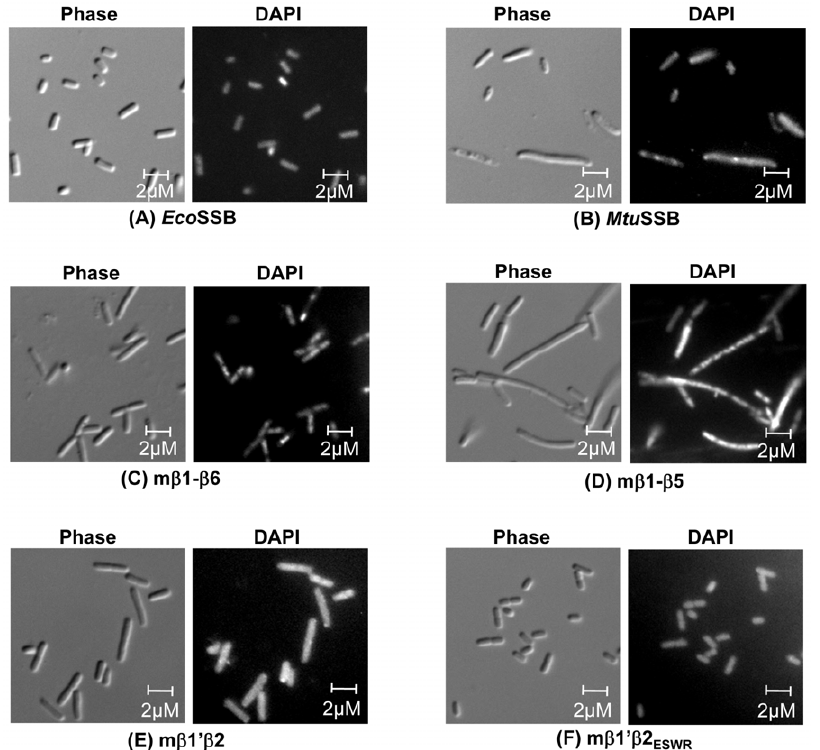
Figure 8. Microscopic observations of E.coli D ssb::kan supported by various SSB constructs. Phase contrast, and DAPI stained images, as marked, are shown on the left and right sides, respectively of each panel.